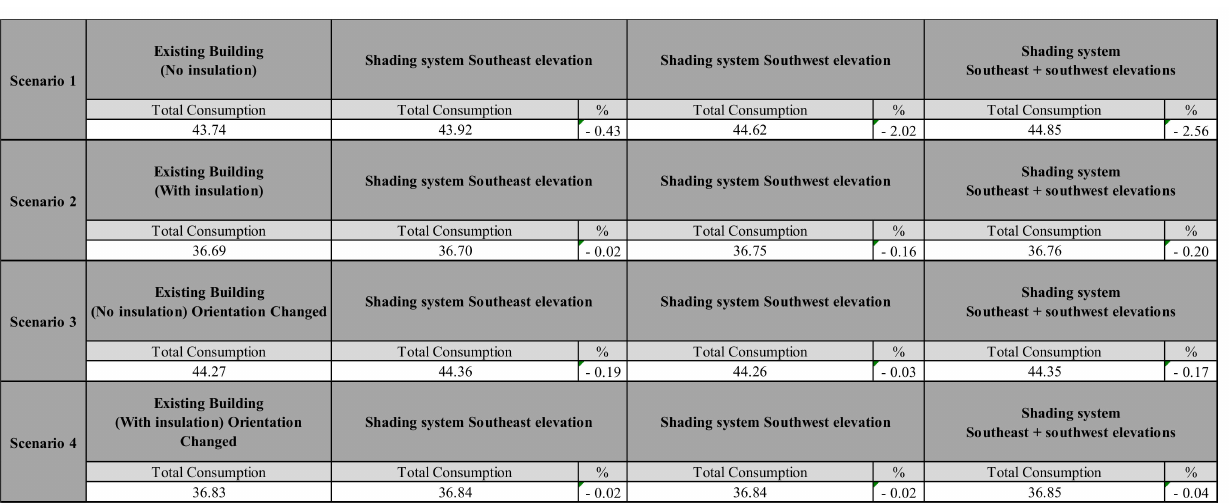
Figure 16. Calculation of final energy consumption with DesignBuilder (kWh/m 2 year) and the improvement (%) of the shading